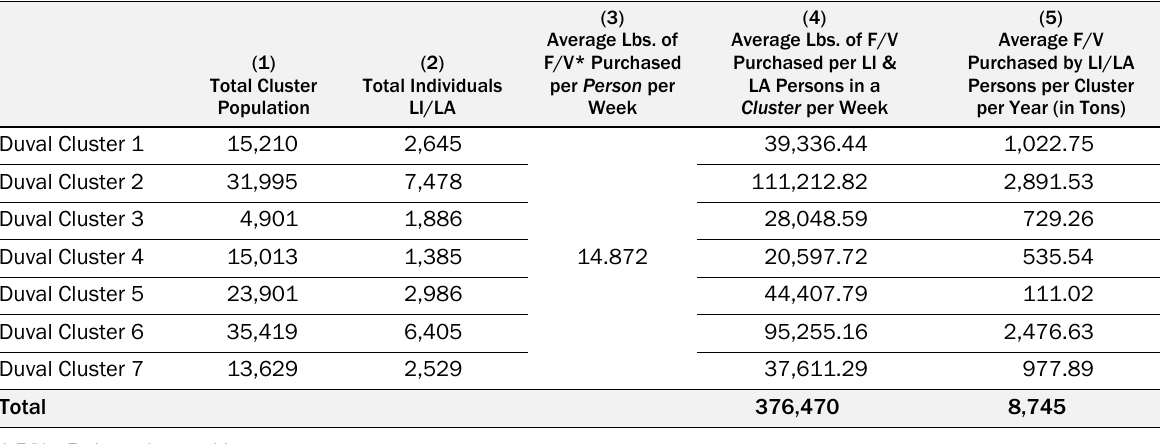
Table 2. Estimated Annual Amount of Fruits and Vegetables Purchased by Low-income (LI) and Low-access (LA) Individuals in Food Desert Clusters in Duval County, Florida, by Multiplying the Product (4) of the Total Number of Low-access and Low-income Individuals (2) and the Average Pounds of Fruits and Vegetables Purchased per Person per Week (3) by 52 Weeks and Dividing by 2,000 Pounds To Convert to Tons (5)